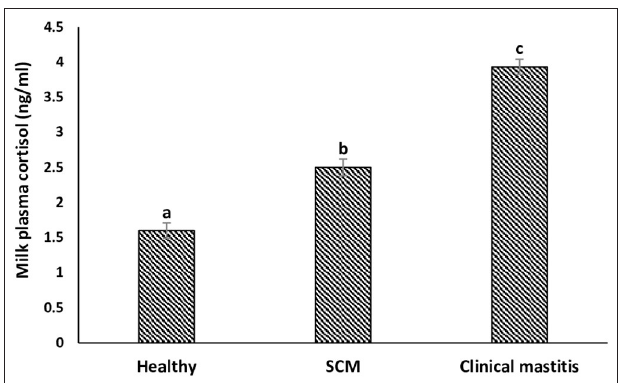
FIGURE 8 | Milk plasma cortisol concentration (ng/mL) in healthy, subclinical mastitis (SCM), and clinical mastitis Sahiwal cows. Data were expressed as mean ± SEM. Means statistically ( p < 0.05) different between the groups are shown with small superscript letters